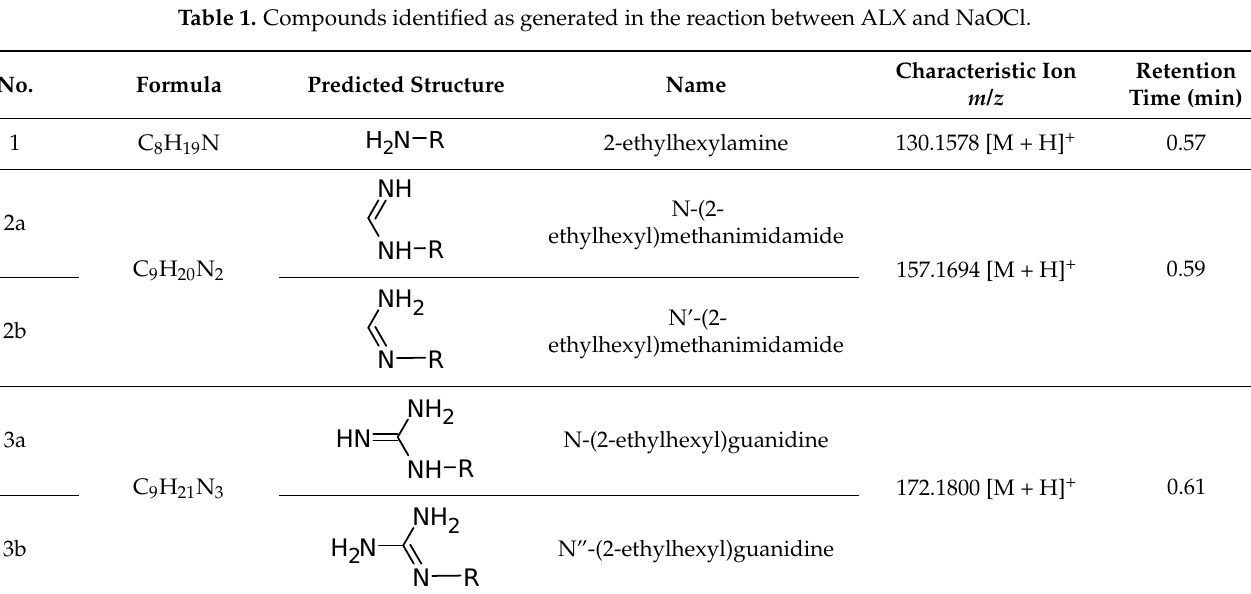
. Table 1. Compounds identified as generated in the reaction between ALX and NaOCl